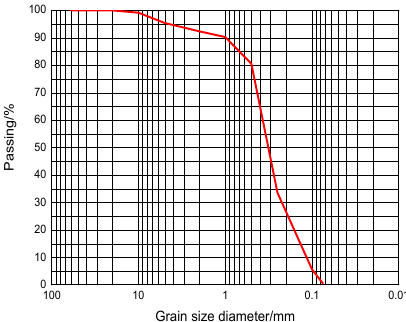
Figure 6. Grain size diagram.